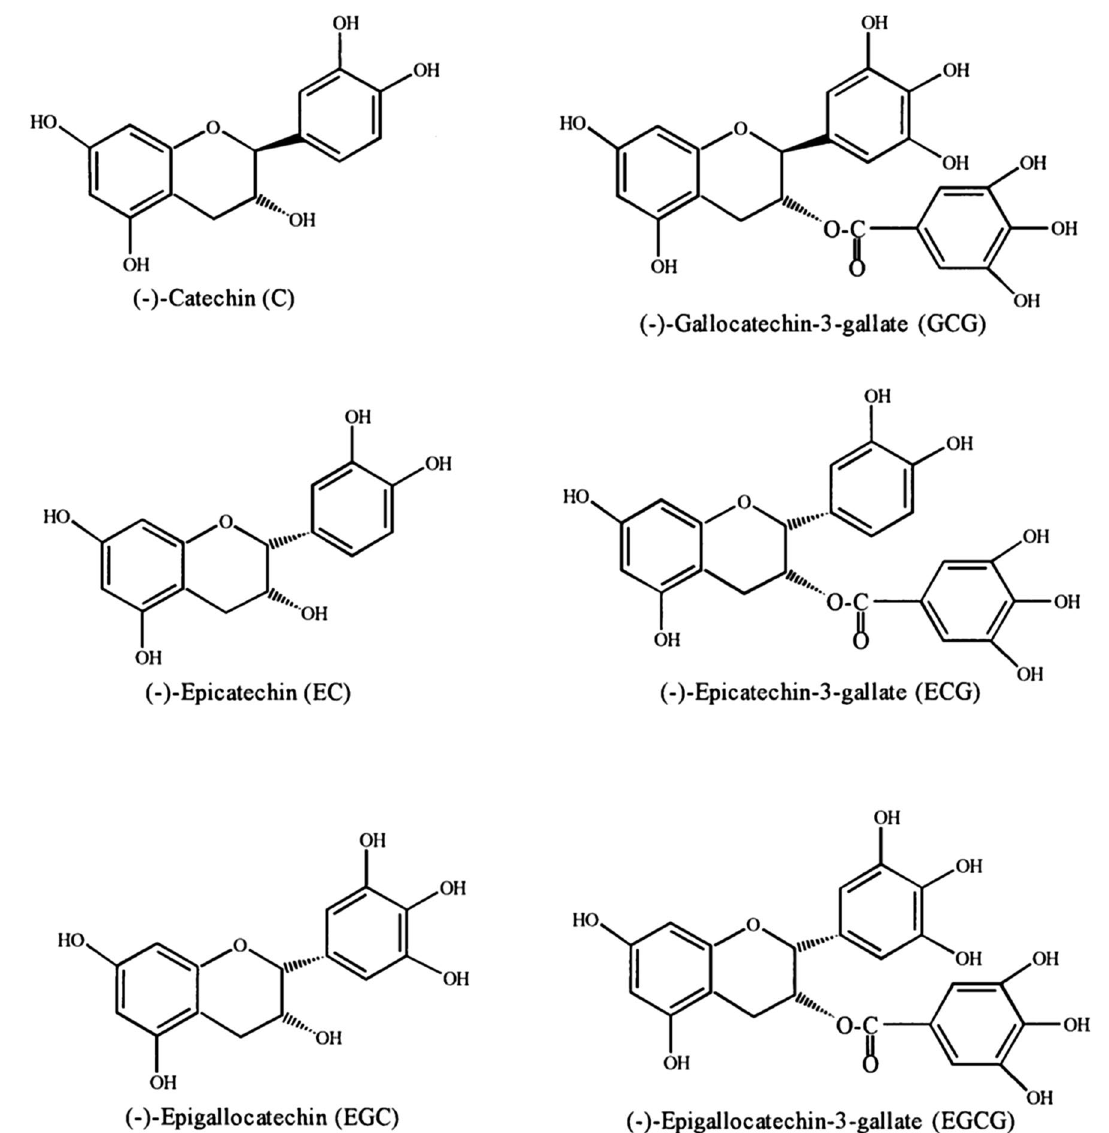
Fig. 2 Structure of catechins: catechin [( +)-3,3 ′ ,4 ′ ,5,7-pentahy- droxyflavan)],